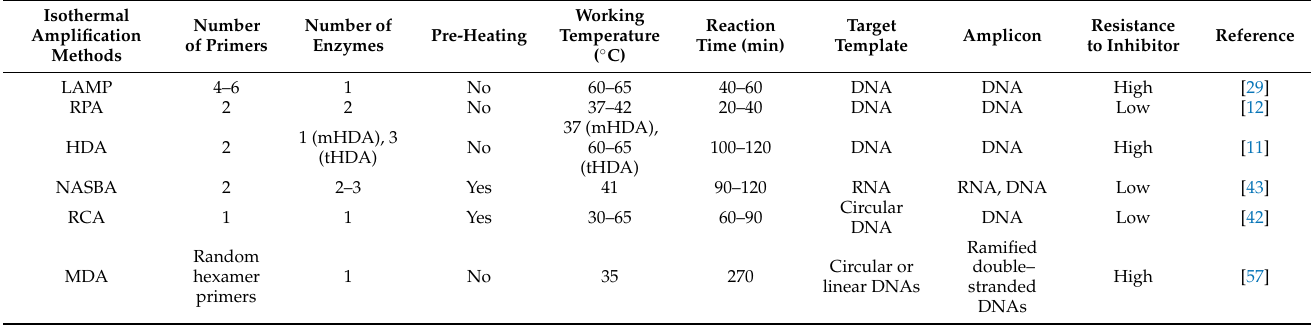
Abbreviations used in the table: LAMP, loop-mediated isothermal amplification; RPA, recombinase polymerase amplification; HDA, helicase-dependent amplification; mHDA, mesophilic form of HDA; tHDA,